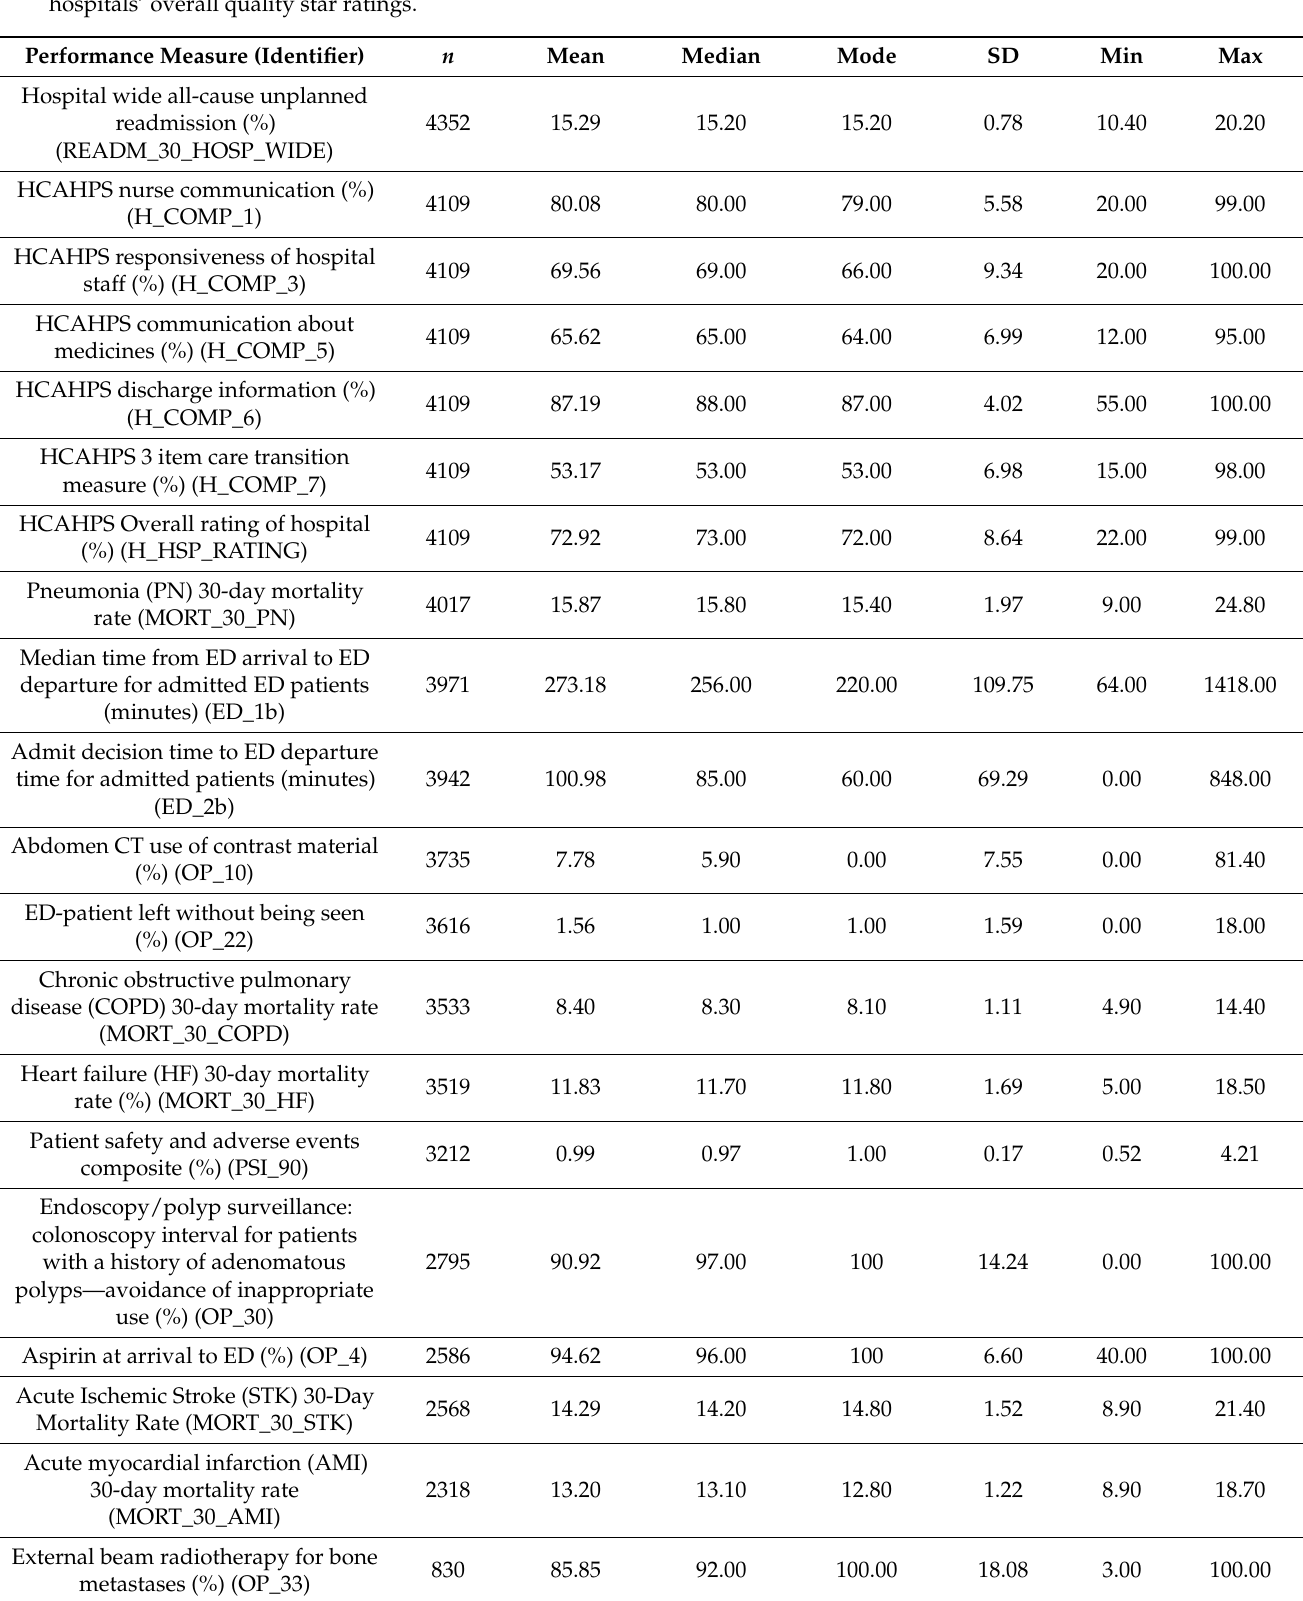
Table 2. Descriptive statistics prior to standardization for statistically significant performance measures associated with hospitals’ overall quality star